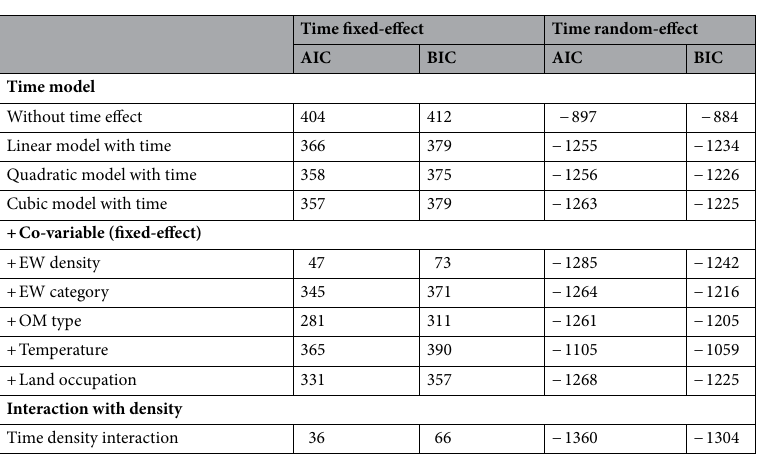
Table 1. Comparison between different mathematical models of the logarithm of the ratio between CO 2 and EW and CO 2 in CTL using different explicative variables. The comparison is based on the statistical criteria AIC (Akaike Information Criterion) and BIC (Bayesian Information Criterion). Lower AIC and BIC values indicate a better fit with the experimental data. The models with random temporal effects consider that data belonging to the same treatments are not independent, and the models with fixed temporal effects consider each datapoint to be independent from the